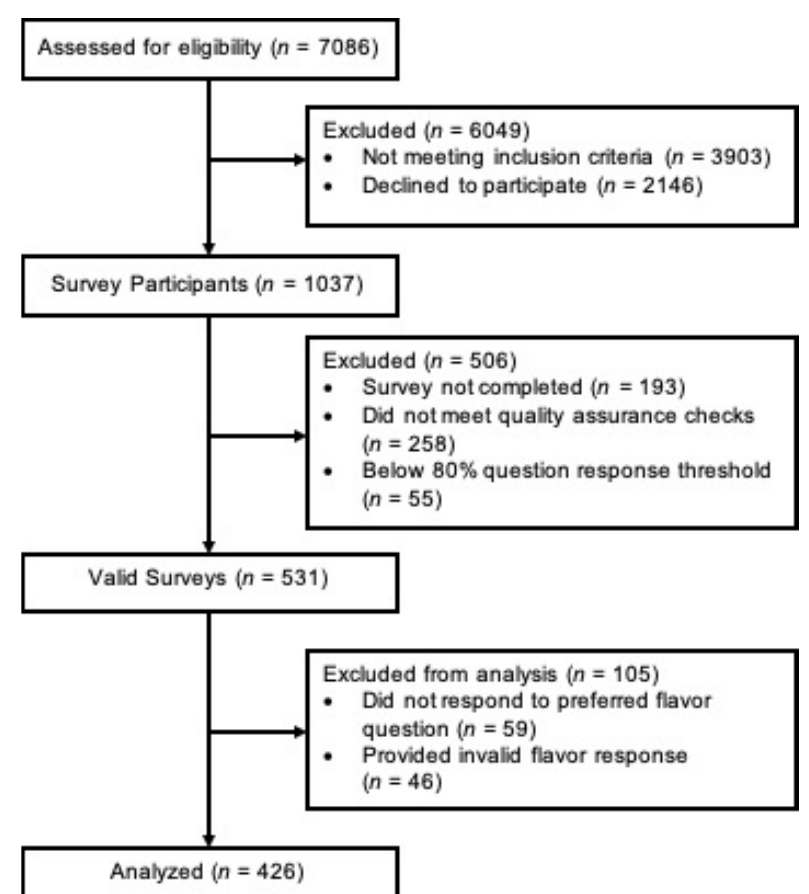
Figure 1. Sample recruitment and analysis.